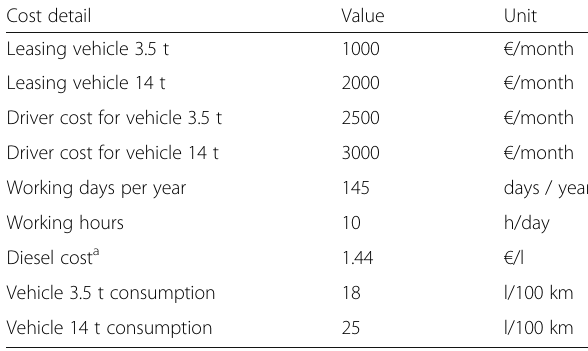
Table 6 Main economic values related to service settings